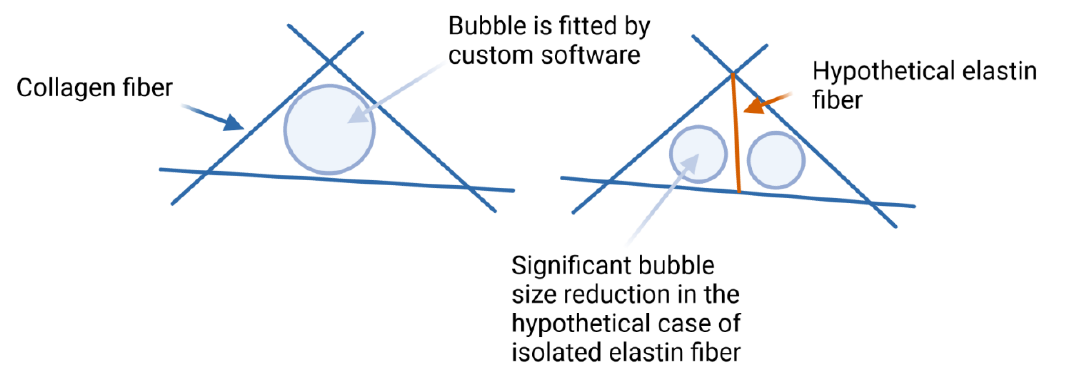
Figure 7. Drawn intersection of collagen fibers (blue lines), which enclose a pore (circle); however, a hypothetical elastin fiber (red line) will divide the pore in two much smaller pores. As we did not see a significant decrease in the pore size, the only other mechanism must be lateral